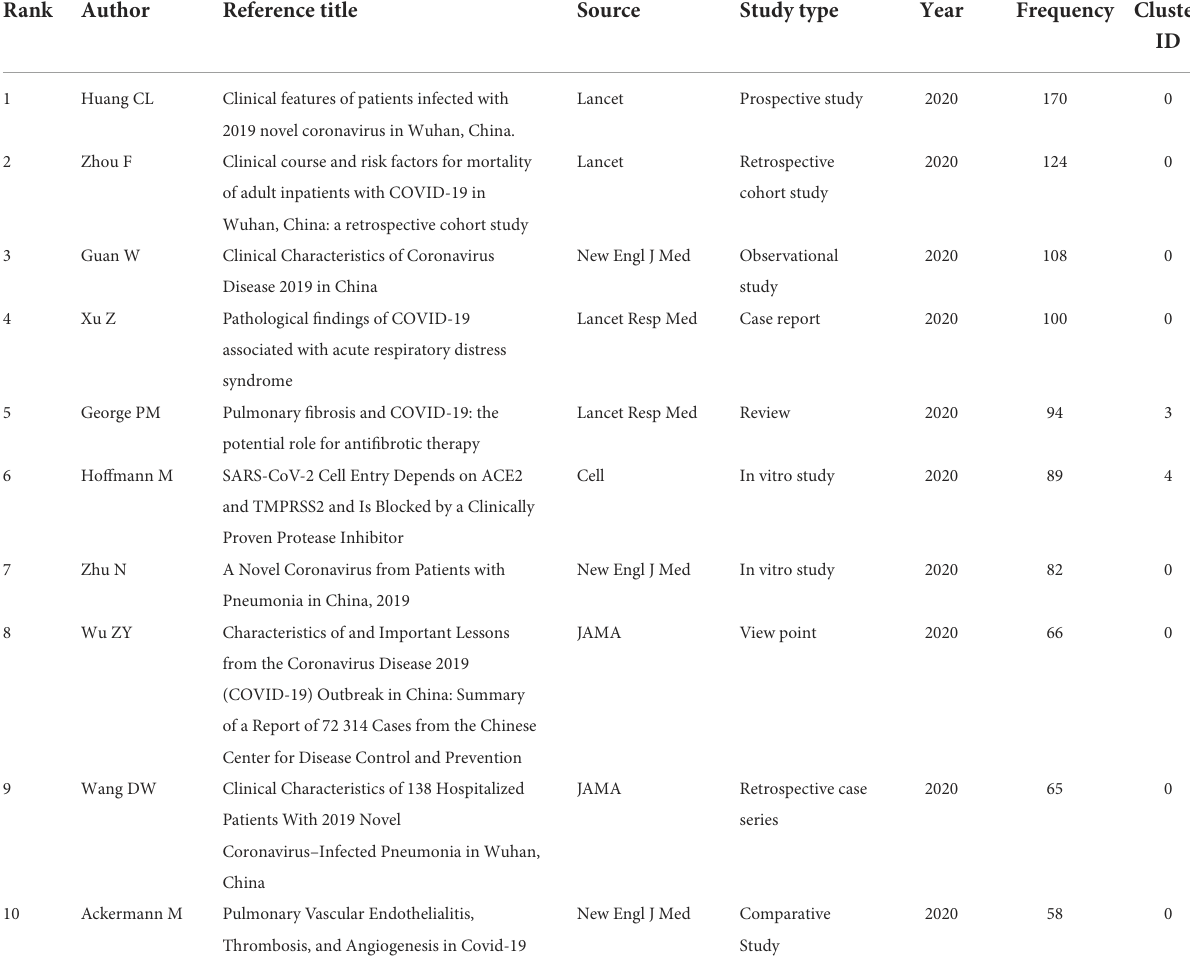
TABLE 2 The ranking of top 10 most co-cited publications in the field of COVID-19-associated fibrosis.